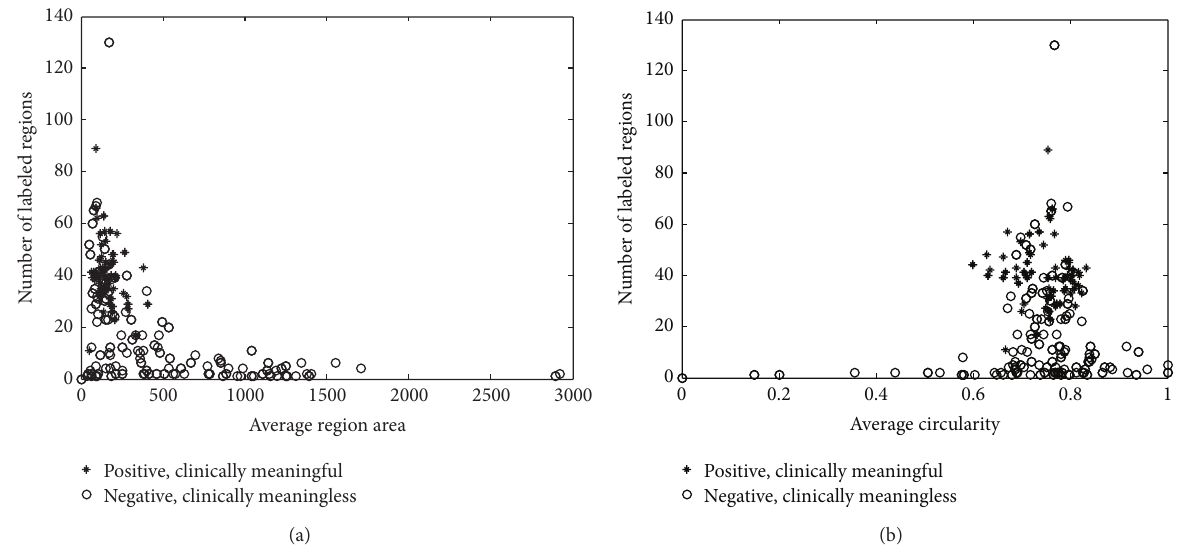
Figure 2: The feature scatter diagram of dataset. It contains 67 clinically meaningful and 133 clinical unanalyzable chromosomes. The vertical axis reflects the number of labeled regions, while the horizontal axis represents (a) average region area, (b) average region